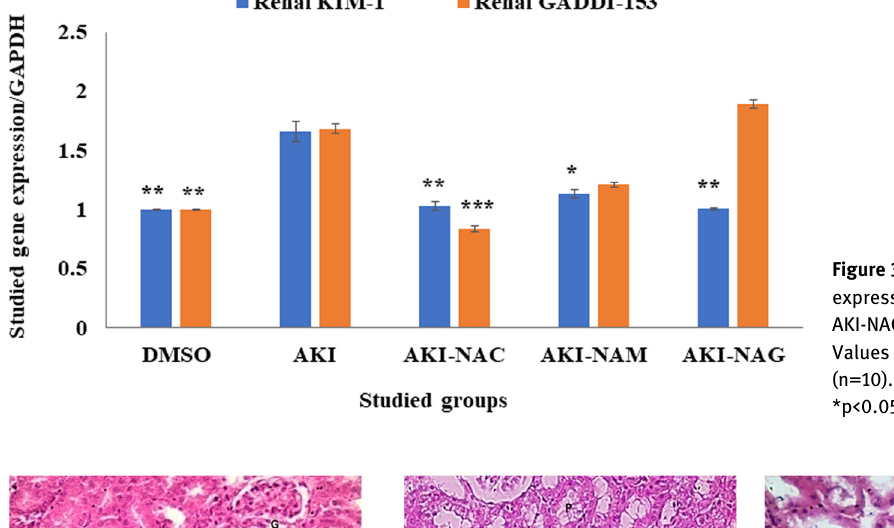
Figure 3: KIM-1 and GADDI-153 gene expression in renal tissue of DMSO, AKI, AKI-NAC, AKI-NAM and AKI-NAG groups. Values were expressed as mean ± SE (n=10).Signi fi cance:***p<0.001, **p<0.01, *p<0.05 comparing